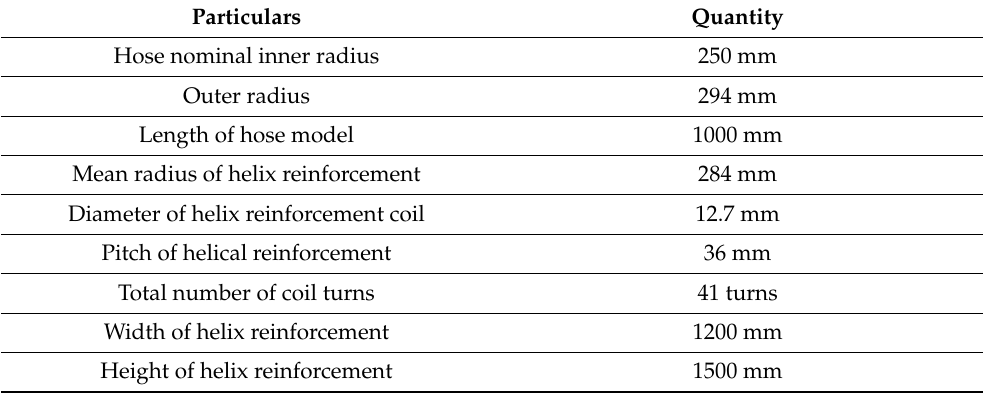
Table 7. Particulars for helix reinforcement and marine bonded composite hose (MBCH)